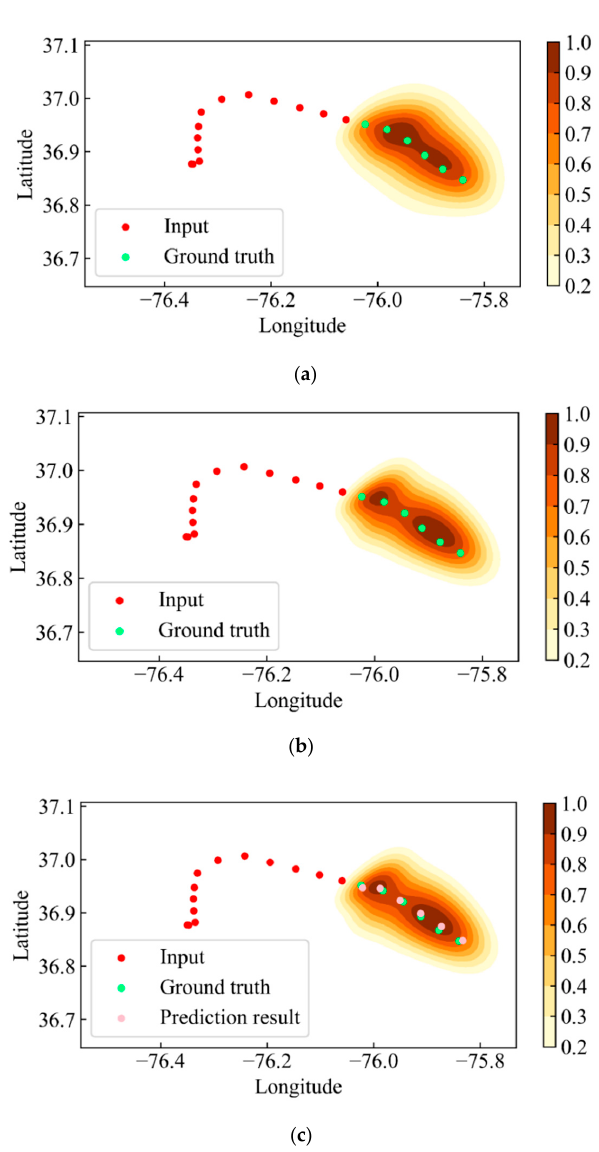
Figure 11. Visualization of the sampling process from the output of the BiRMDN. ( a ) Generating mixture distribution. ( b ) Determining the Gaussian component. ( c ) Sampling from the chosen Gaussian distribution.